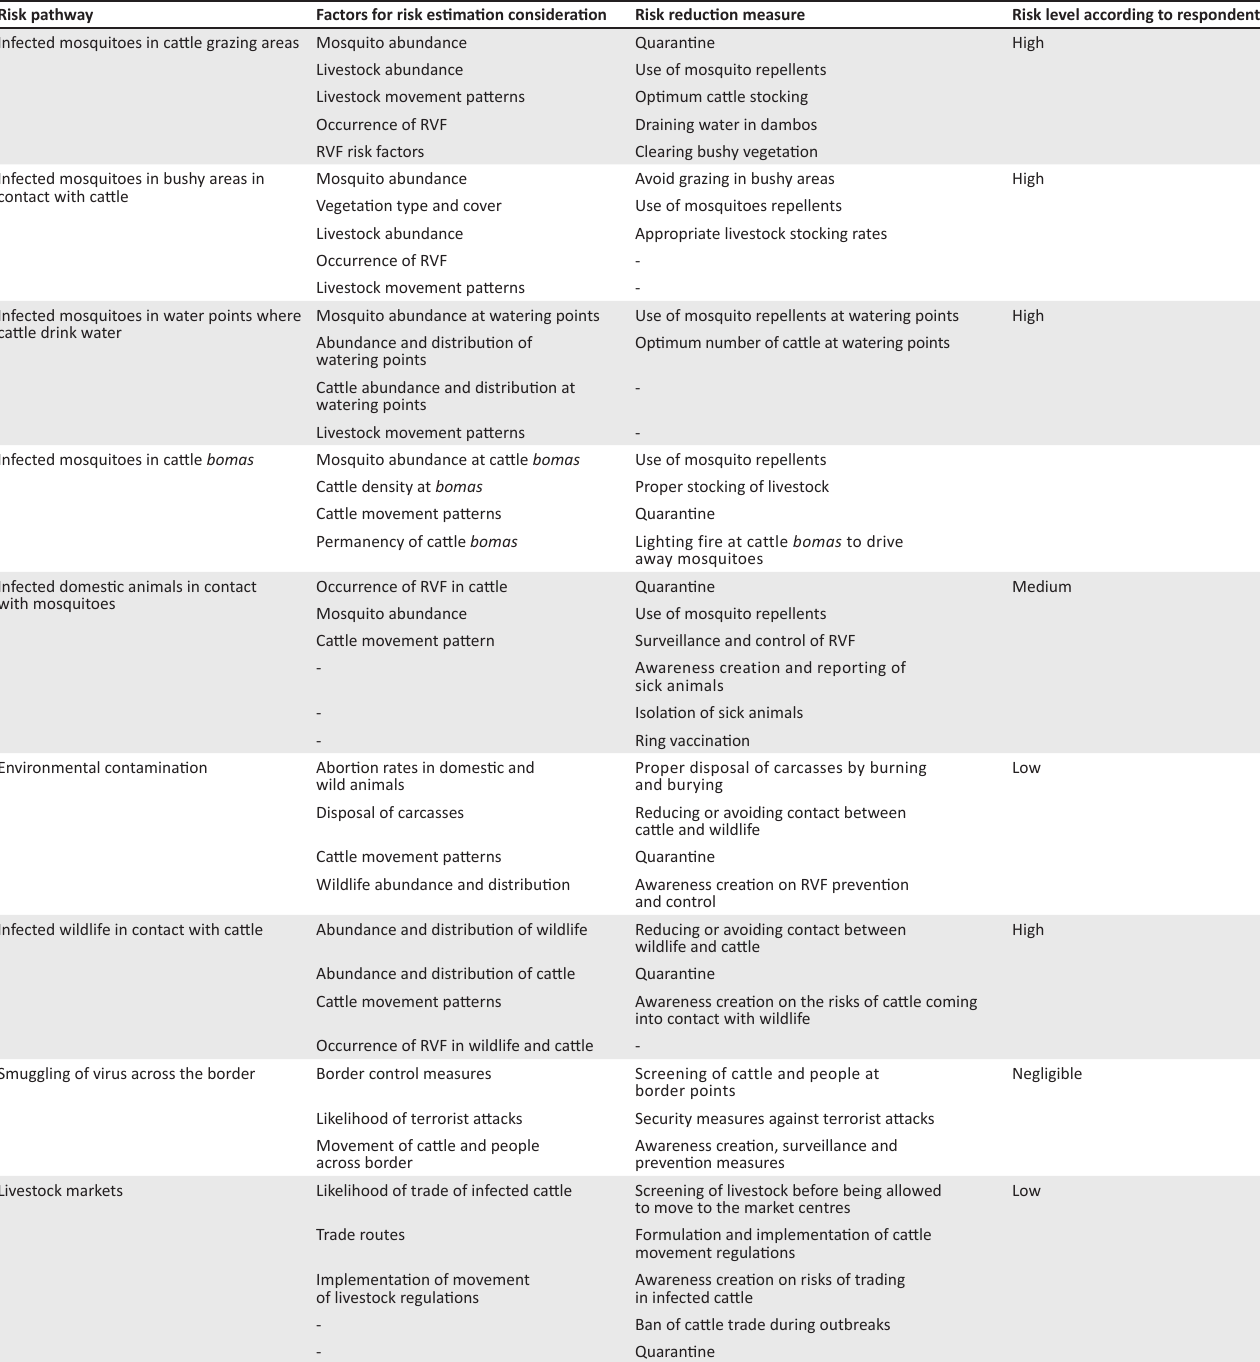
TABLE 5: A summary discussion table of risk pathway analysis for Rift Valley fever in cattle in Ijara, Kenya. Risk